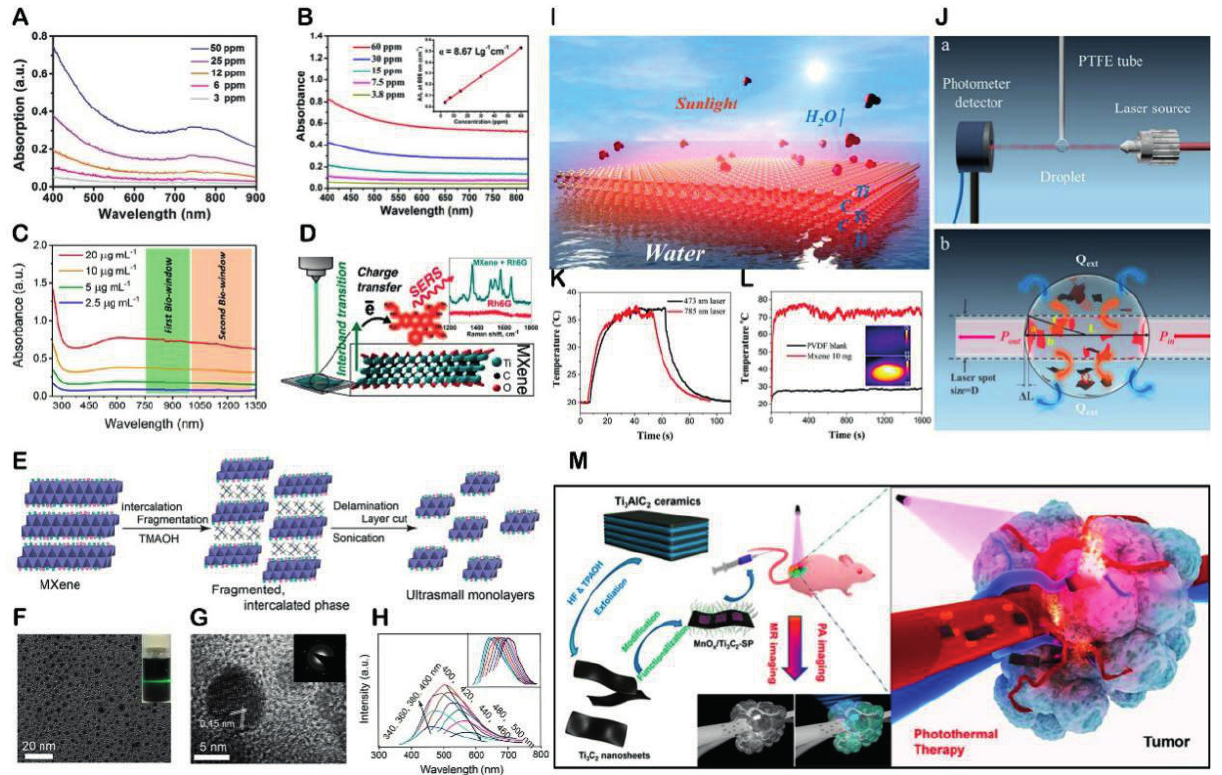
Figure 3: Properties of various MXene